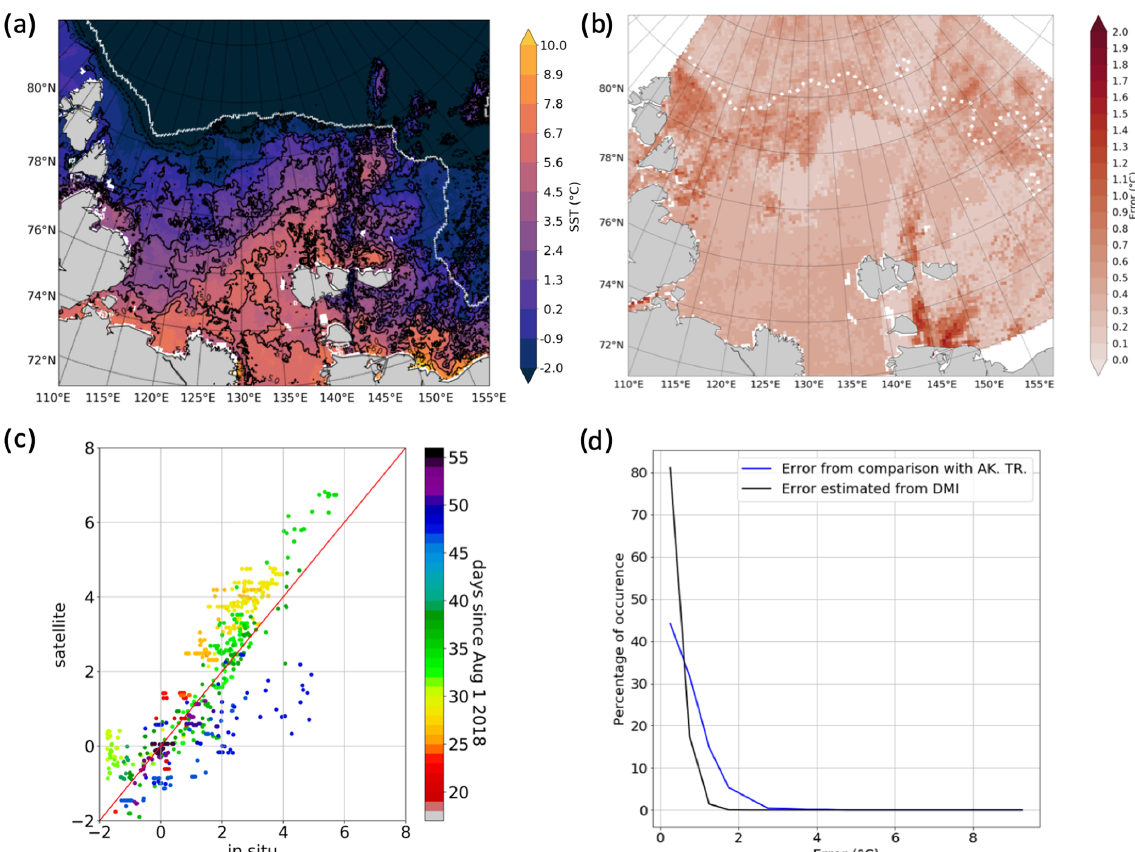
Figure 4. Sea surface temperature validation shown with an example of a DMI SST L4 image for 13 September (a) and the same image shown with the error estimates (b) , a comparison of colocated SST and in situ data (CTD and TSG) in the upper 6.5m (c) , and the distribution of uncertainty provided by DMI and absolute difference derived from comparison with in situ data (d)